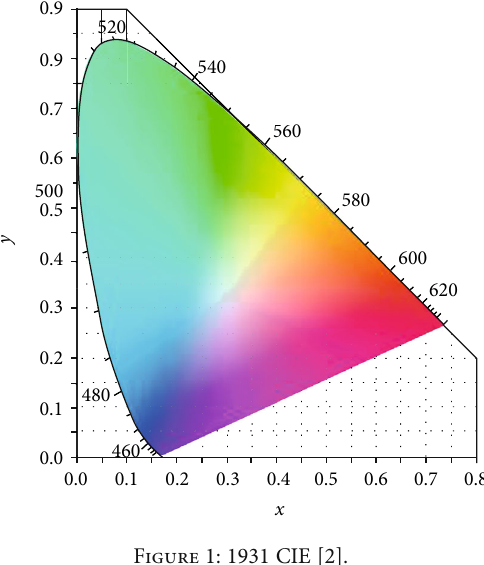
Figure 1: 1931 CIE